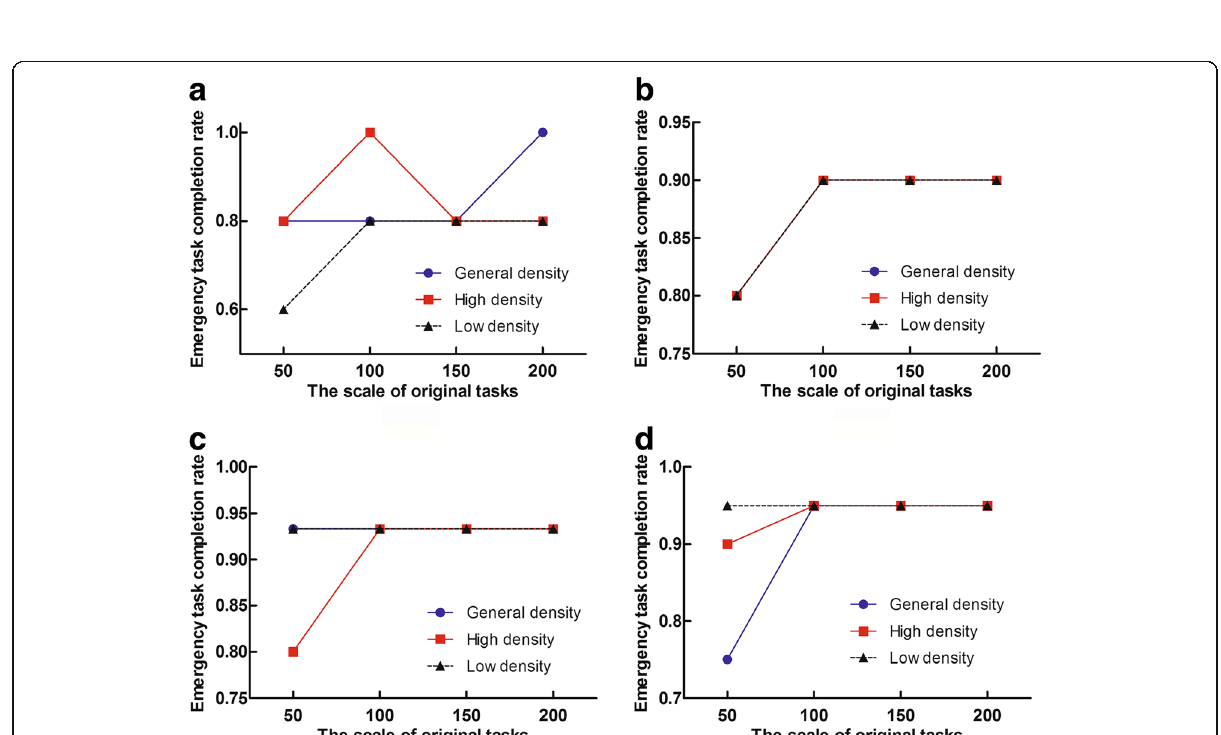
Fig. 6 The completion of emergency tasks ( a , b , c , d )